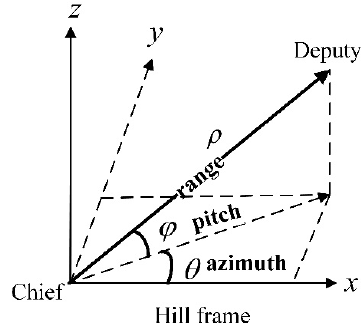
Figure 3. Inter-satellite range and angle measurements in the chief’s Hill frame.